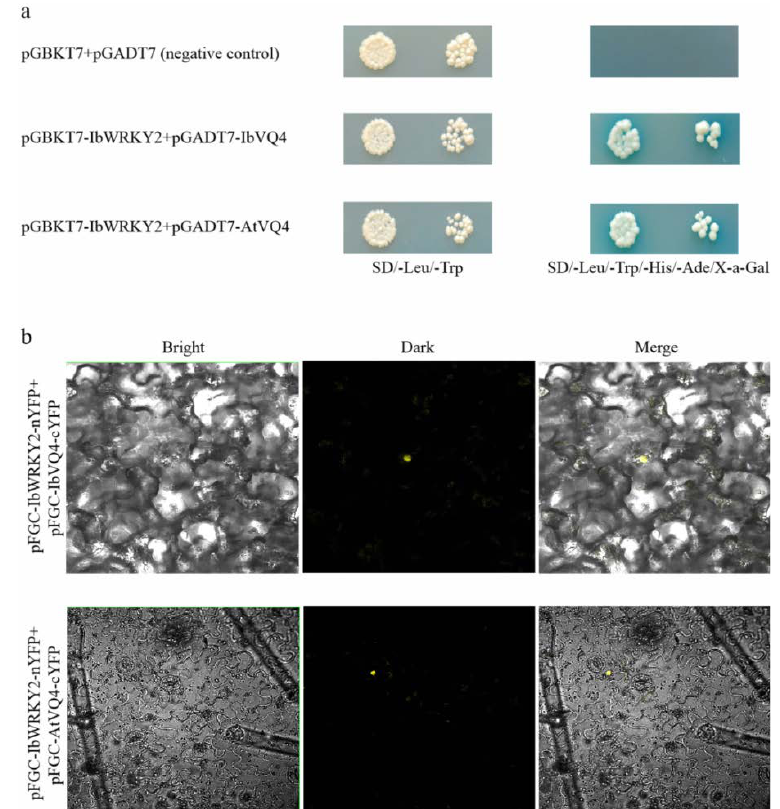
Figure 10. Protein interaction assays between IbWRKY2 and VQ4. ( a ) Yeast two-hybrid assay showing the interaction between IbWRKY2 and VQ4 proteins from sweetpotato and Arabidopsis ; pGBKT7 and pGADT7 plasmids served as negative controls. ( b ) BiFC visualization of the interaction between IbWRKY2 and VQ4 proteins from sweetpotato and Arabidopsis in tobacco leaves.